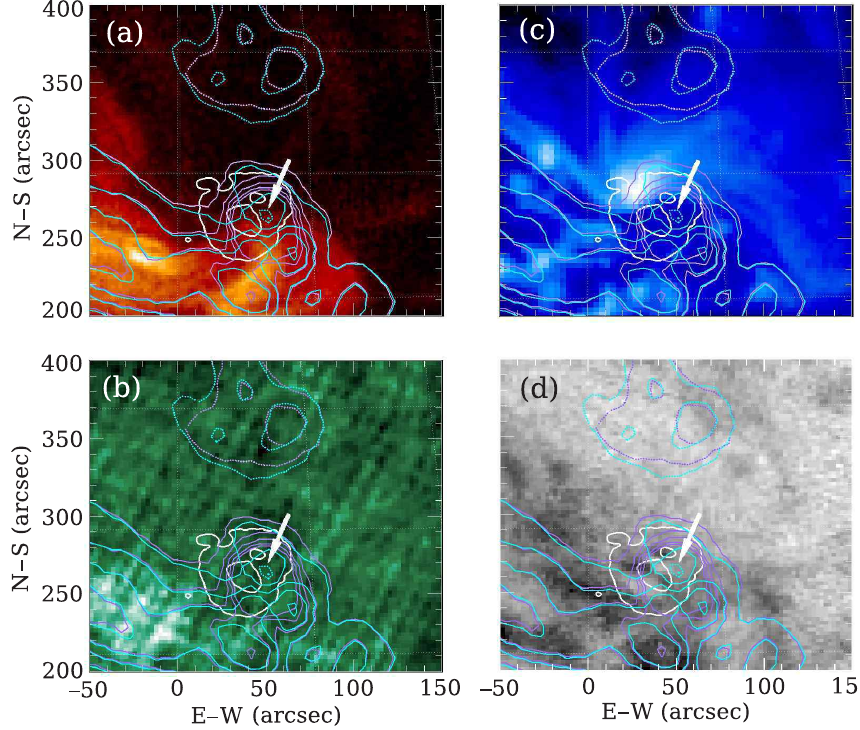
Fig. 1. AR 11289 on September 13. The contours of the 17 GHz radio brightness in LCP (violet color) and RCP (azure color) at the levels (5, 10, 15, 20) (cid:2) 10 3 K and (15, 20, 25, 30, 35, 40) (cid:2) 10 3 K respectively, and the dotted line at (8.5, 9.5, 1.05) (cid:2) 10 3 K observed at 03:50 UT are overlaid on: (a) the soft X-ray image taken with the XRT onboard Solar-B at 07:04 UT, (b) the NoRH image of the 34 GHz intensity taken at 02:44 UT, (c) EUV 1 : 74 (cid:2) 10 (cid:0) 8 m image taken with the SWAP with Al (cid:12)lter onboard the PROBA2 at 02:43 UT, and (d) the image in the chromospheric absorption line He I 1.083 (cid:22) m taken with the CHIP at the Mauna Loa Solar observatory at 18:45 UT Note the faint emission in both coronal (a, c) and chromospheric (b, d) levels of the atmosphere above the northern part of the sunspot. Contours of the sunspot umbra and penumbra are marked by the white